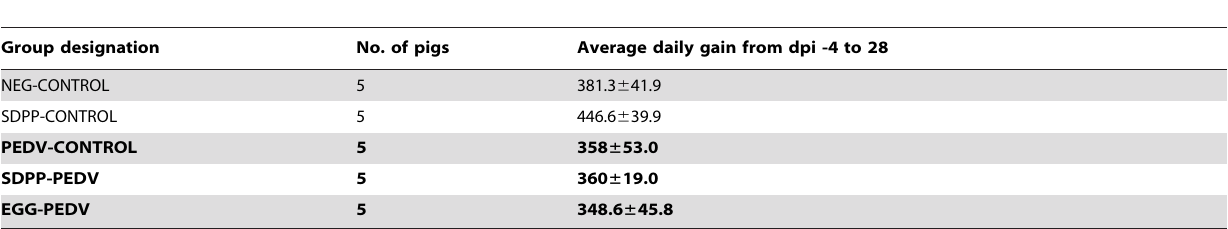
Table 2. Average daily gain in grams ( 6 SEM) as determined on all pigs that were kept until 28 days post